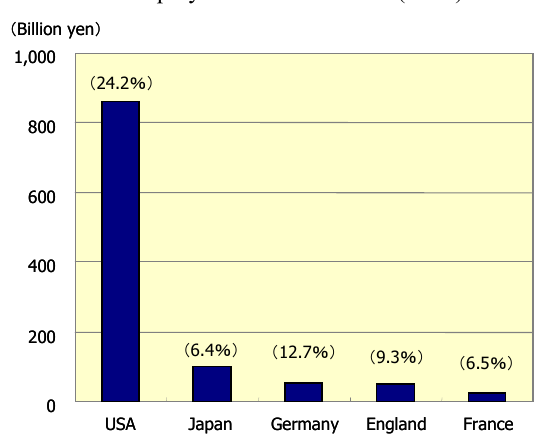
Figure 2. The Ratio of Individual